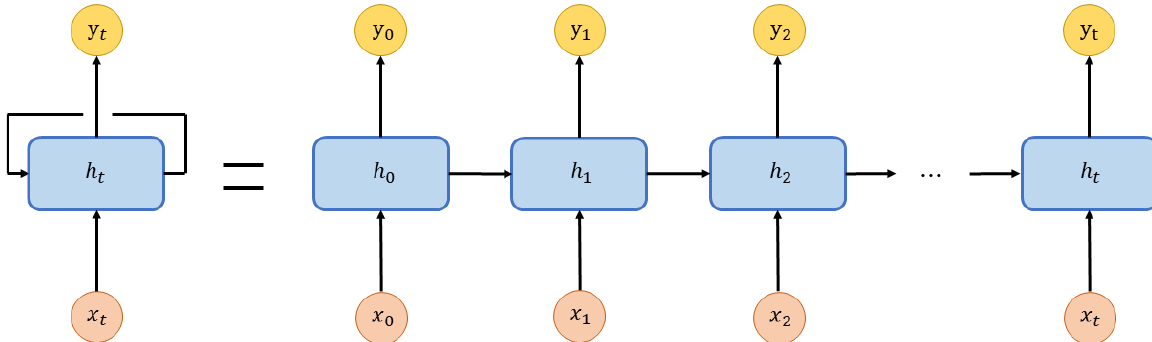
Figure 1. Structure of RNN.